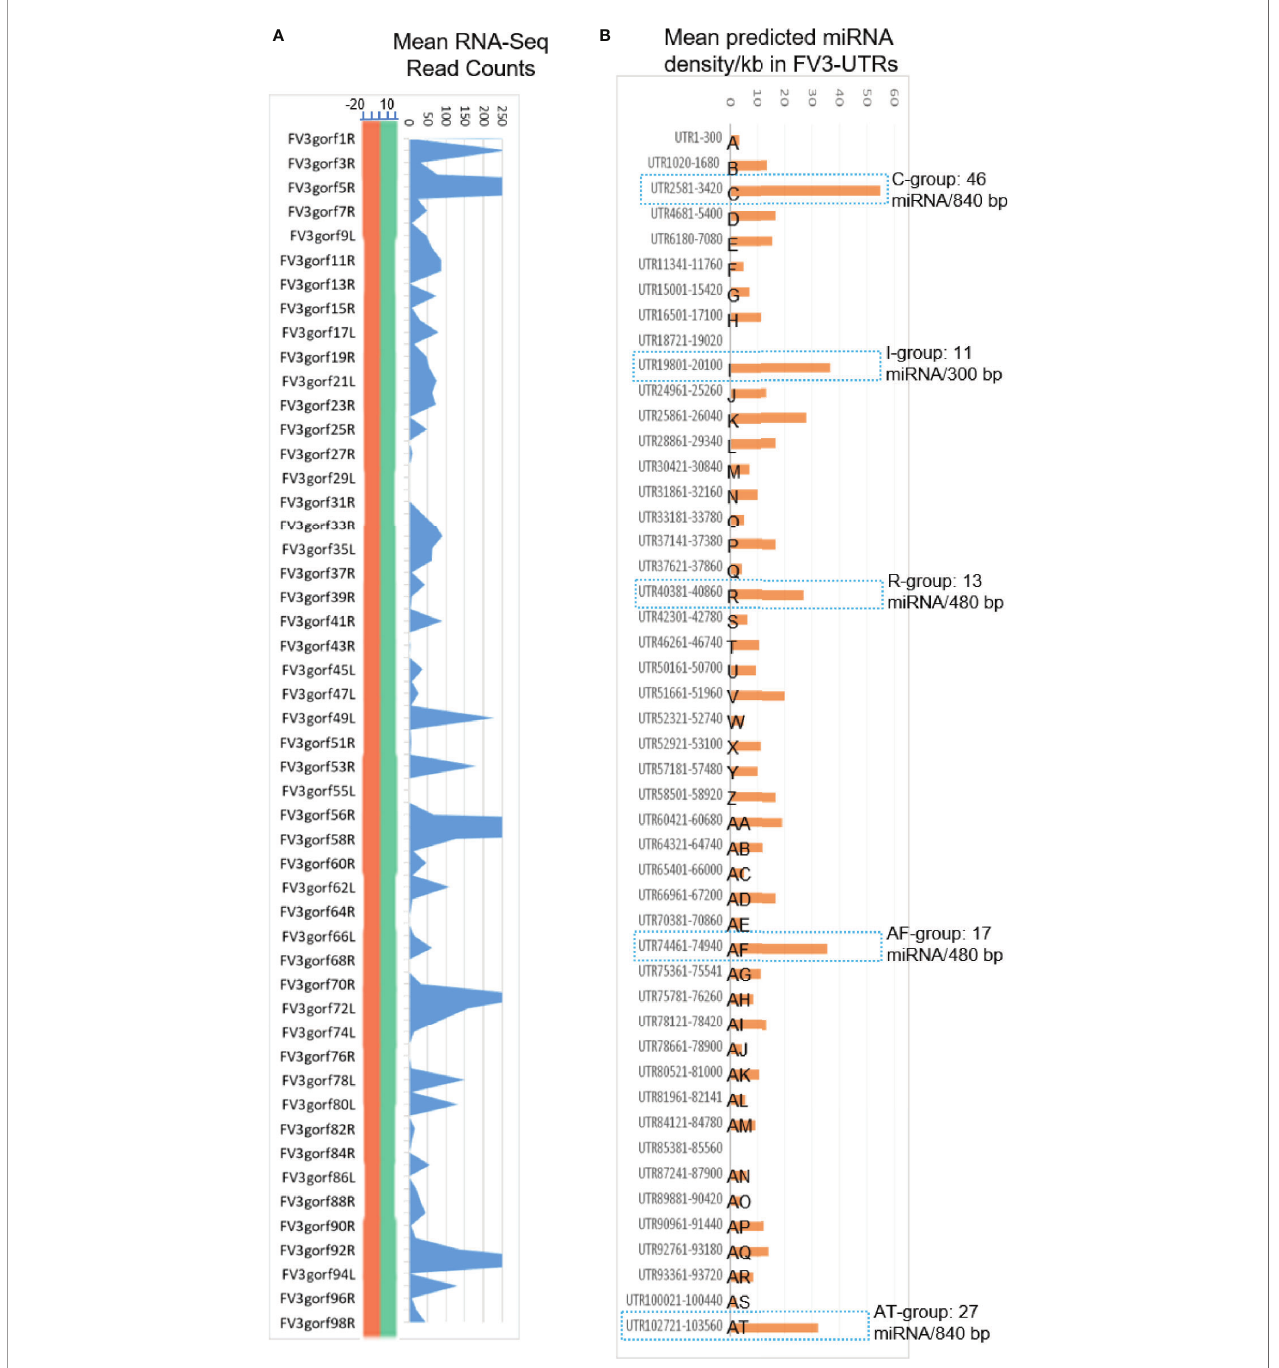
FIGURE 6 | Comparison of transcriptomic and enrichment of putative microRNA (miRNA) sequences in intergenic regions of FV3 genome. (A) As line chart in Figure 2 , mean RNA-Seq reads are differentially distributed among intergenic regions and almost all annotated FV3 coding ORFs. A distribution plot between the vertical Axis and gene labels, shows the median of read density (Log2 Unit) of mapped reads along the FV3 genome as in the FV3- D 64R-infected kidney to show the full-genome coverage at both positive (green) and negative (orange) strand orientations. Transcription of the intergenic regions along the higher read density spanning the ORF coding genes is shown using the shaded blue curve indicating mean read counts across the eight infected tissues tested. (B) The prediction of miRNA-like sequences in most intergenic regions (marked as UTR start-end site along FV3 reference genome including the 5 ’ - and 3 ’ -untranslated regions), which are especially enriched in fi ve regions (named as C, I, R, AF and AT per putative miRNA density/Kb) as marked using blue dash line. The sequence information of all predicted miRNAs is listed in Supplemental Excel Sheet . The miRNA prediction and target validation were performed using three RNA analysis programs through an online BiBiServ